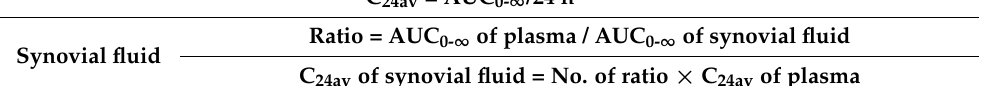
Table 1. Formula for calculation of loading dose, daily dose and target. In steady-state condition in plasma AUC 24h = AUC 0- ∞ LD = V ss /F × target concentration V ss = Cl/F × MRT Plasma target concentration = C 24av in steady-state condition in plasma C 24av = AUC 0- ∞ /24 h Ratio = AUC 0- ∞ of plasma / AUC 0- ∞ of synovial fluid Synovial fluid C 24av of synovial fluid = No. of ratio × C 24av of